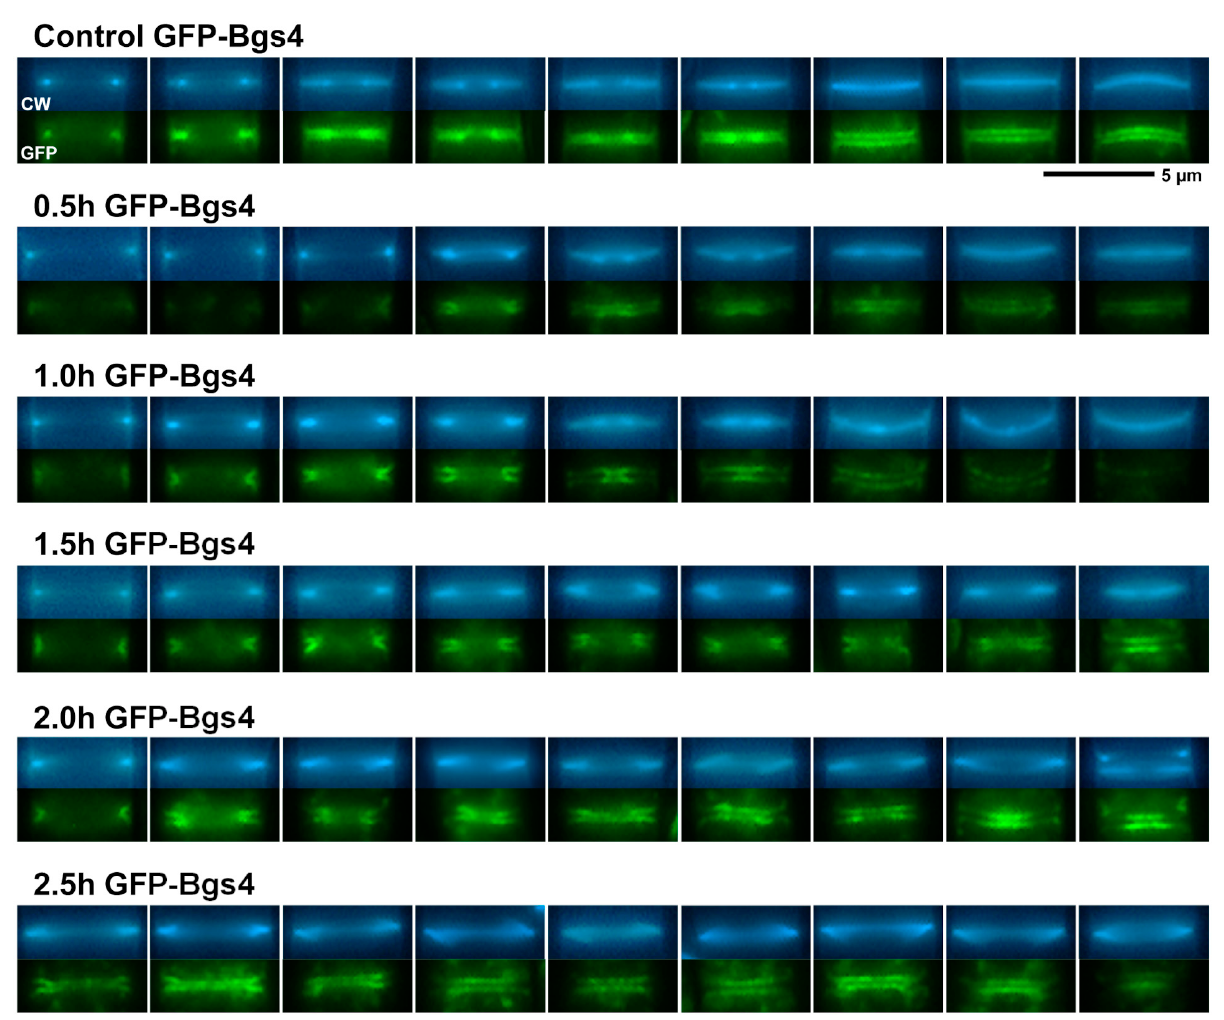
Figure 5. GFP ‐ Bgs4 localization in the septum area in the absence or the presence of lethal doses of caspofungin. Cells were grown and imaged at the indicated times using CW and GFP fluorescence microscopy as in Figure 3 either in the absence (control) or in the presence of 20 μ g/mL of the antifungal. Micrographs are magnifications of the septum area of representative cells in different stages of septum progression. Scale bars: 5 μ m.